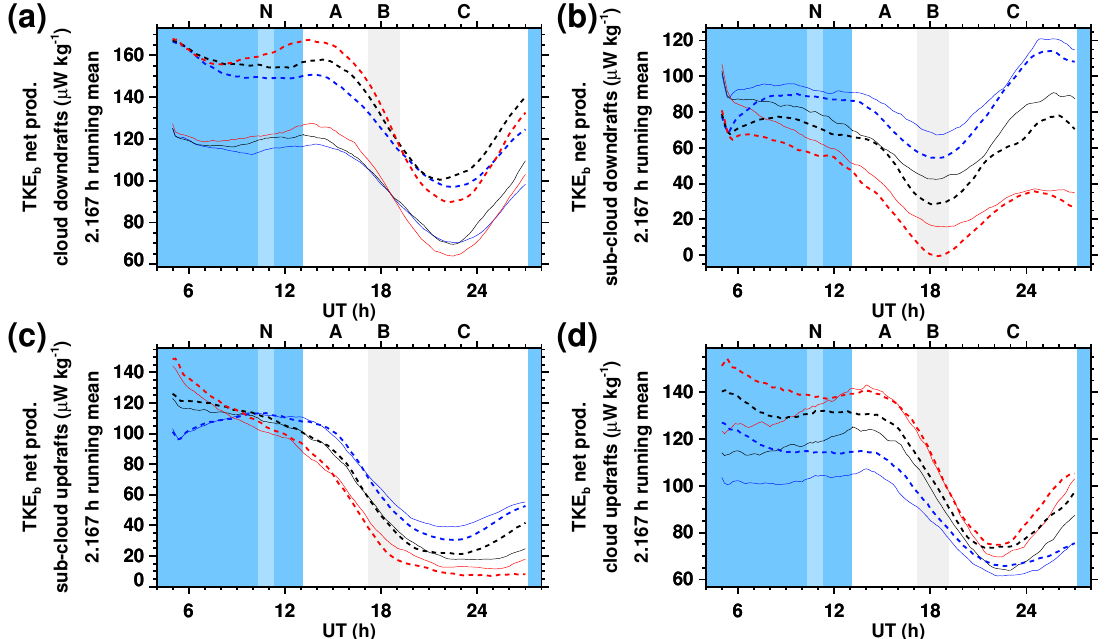
Figure C4. Effect of resolution. Solid curves denote simulations with the base resolution, dashed curves simulations with double resolution in each dimension (Table 2). M − (blue solid), M 0 (black solid), M + (red solid); M − dashed). TKE b denotes buoyant production of turbulence kinetic energy. TKE production rates are given per total boundary layer air mass. A low-pass (running mean) filter was applied where indicated to reduce